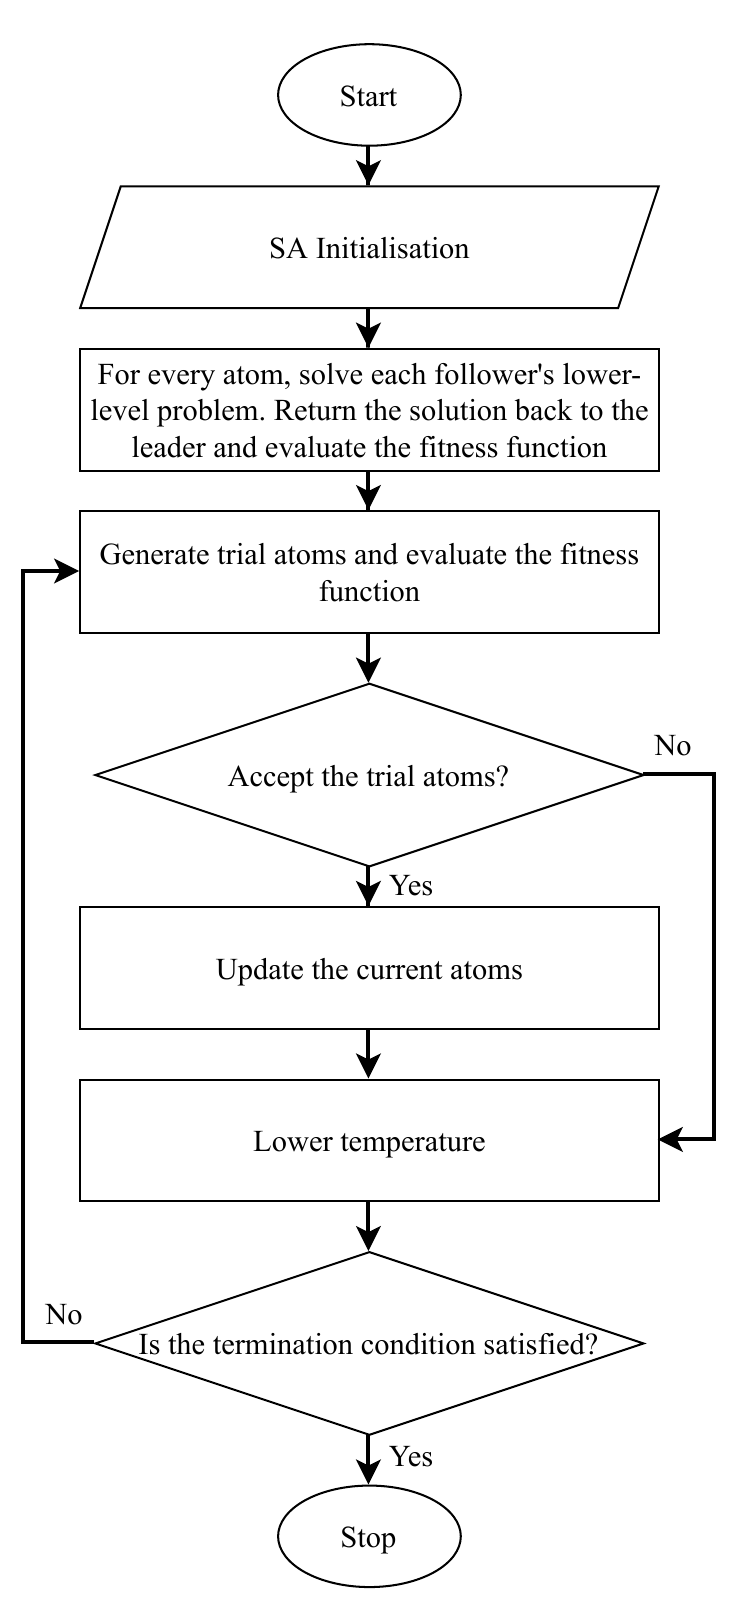
Figure 5. Flowchart of the SA-based